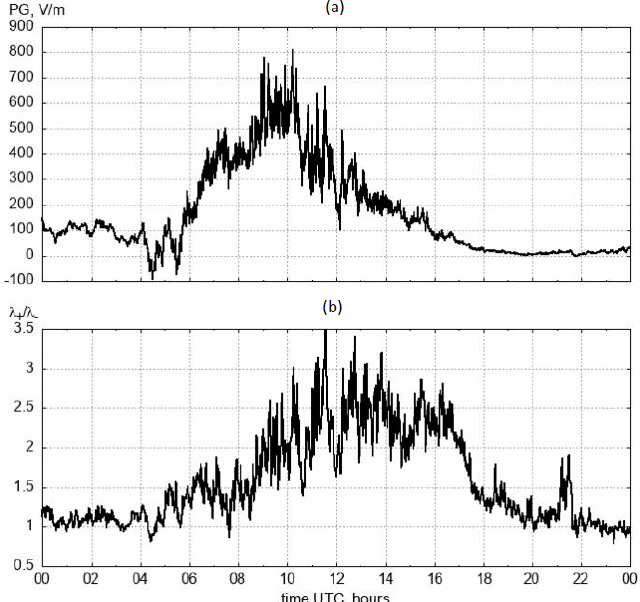
Figure 6. Snow effect for 26 February 2010: ( a ) PG values; ( b ) the value of